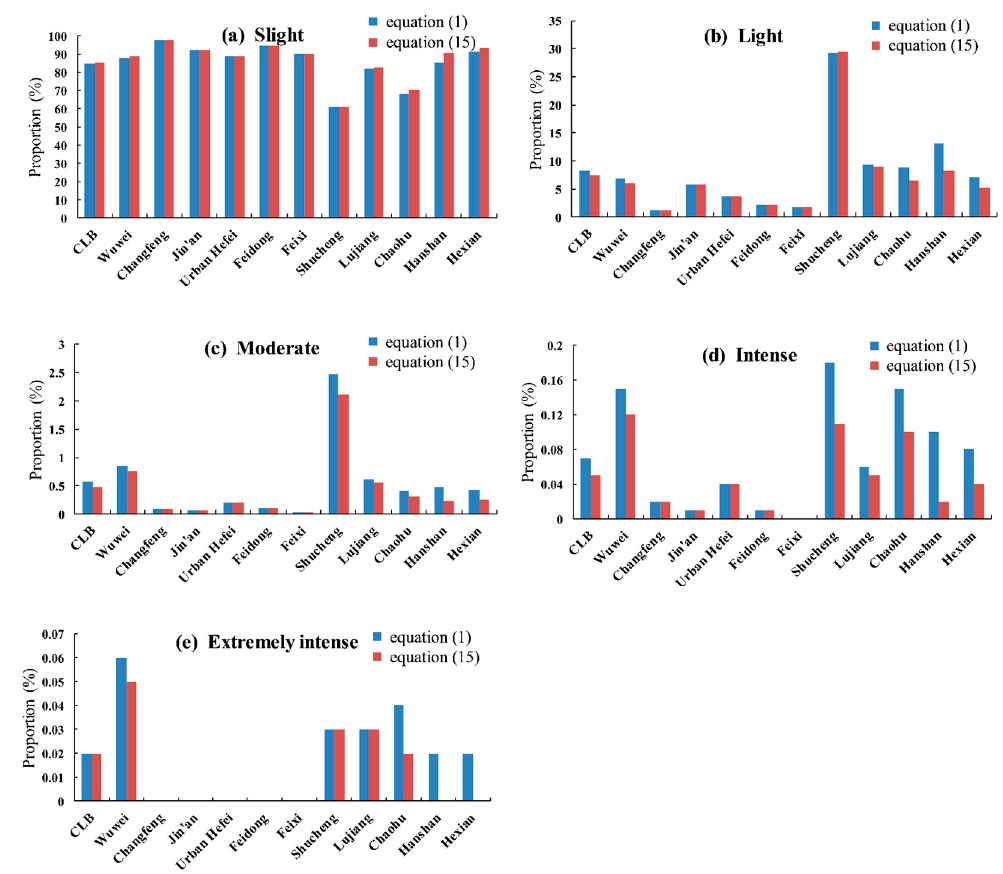
Figure 9. The distribution of soil erosion grade in the CLB and its 11 districts and counties: ( a ) Slight; ( b ) Light; ( c ) Moderate; ( d ) Intense; and ( e ) Extremely intense.